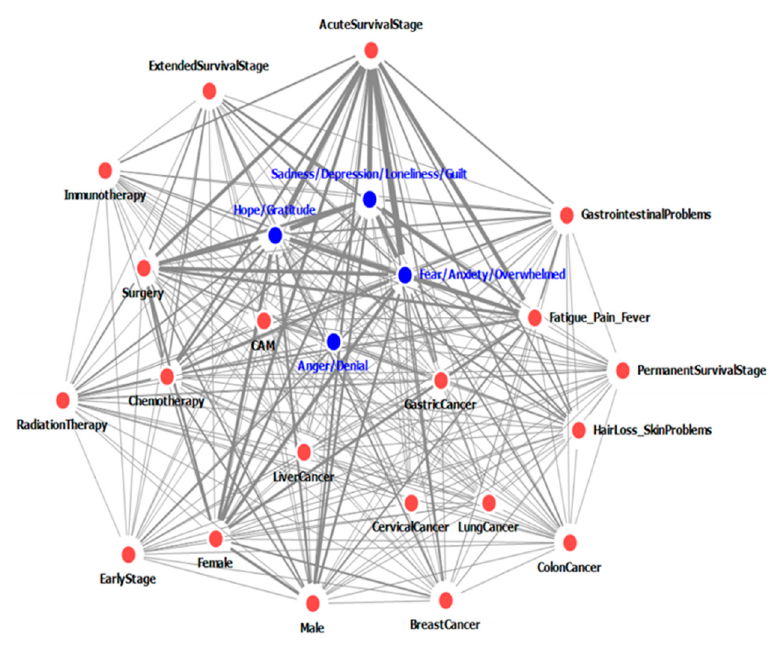
Figure 1. Network of emotion groups concerning cancer and factors affecting emotions groups, as determined through posts on internet blogs, online cafés, and message boards.